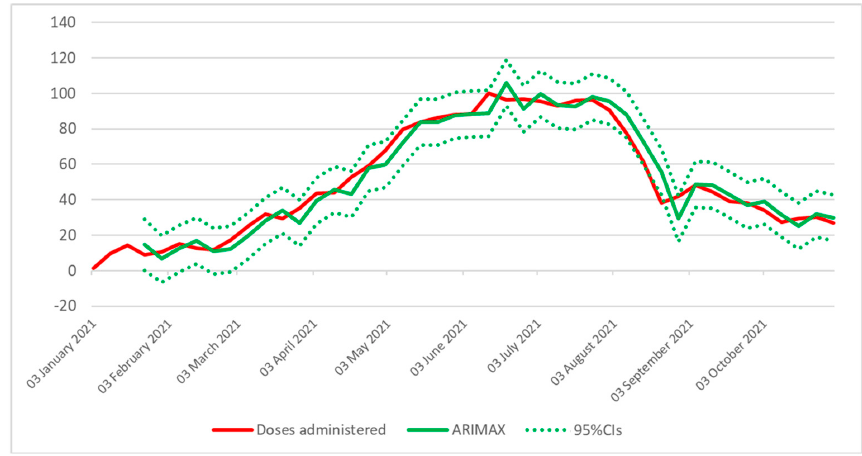
Figure 4. Performance of the ARIMAX model based on Google Trends with a 3-week lag in fitting the number of COVID-19 vaccinations.